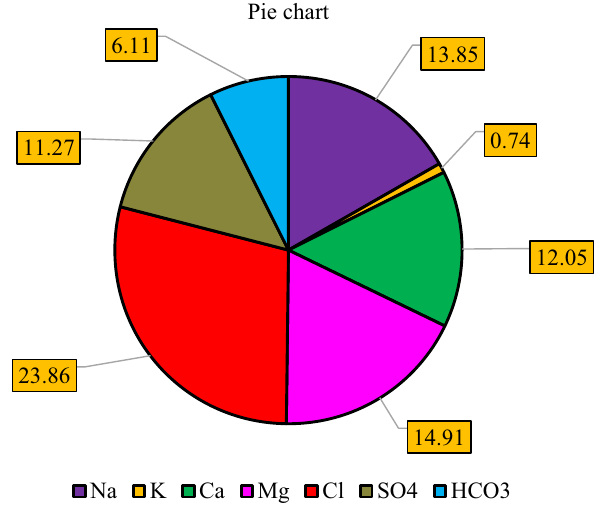
Fig. 4 Pie chart of anions and cations